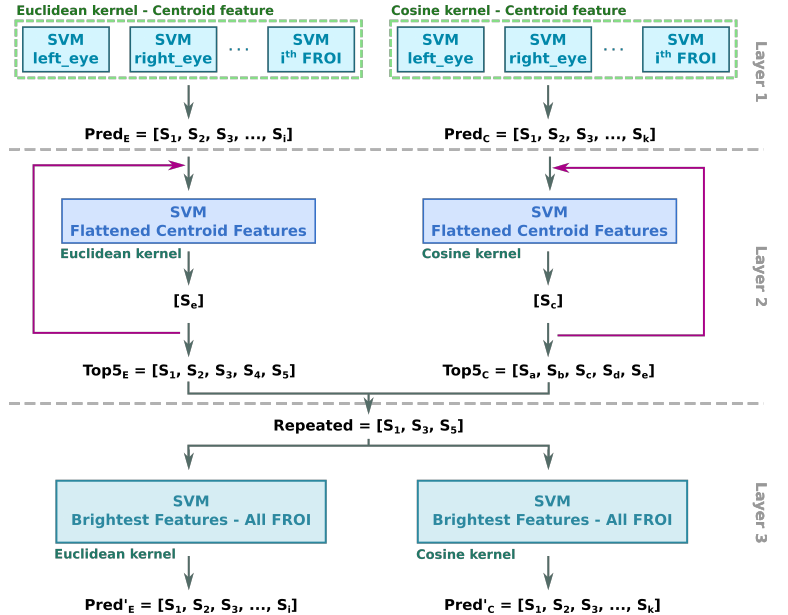
Figure 6. AP-SVM tree for face